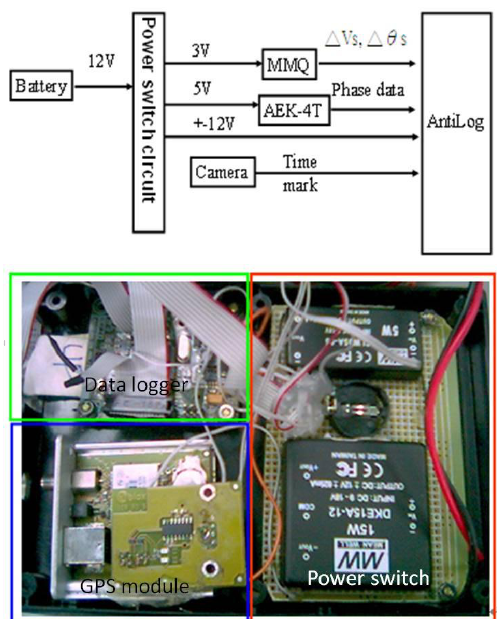
Figure 4 Configuration of DG